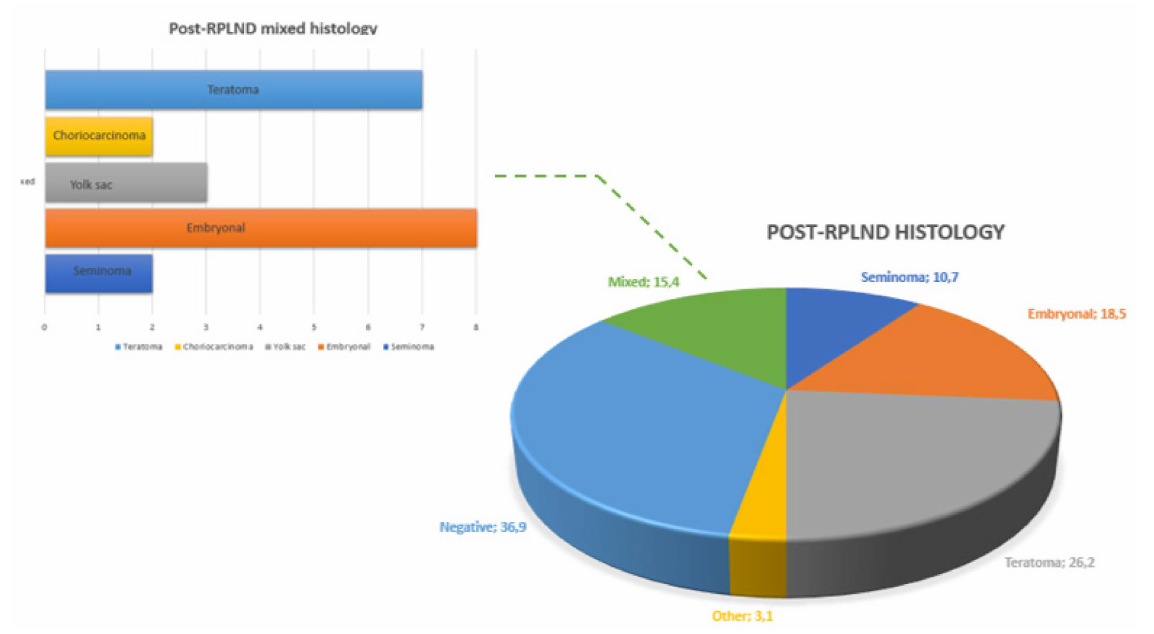
Figure 3. Overall and mixed distribution of testicular cancer histotypes at post-RPLND pathology.